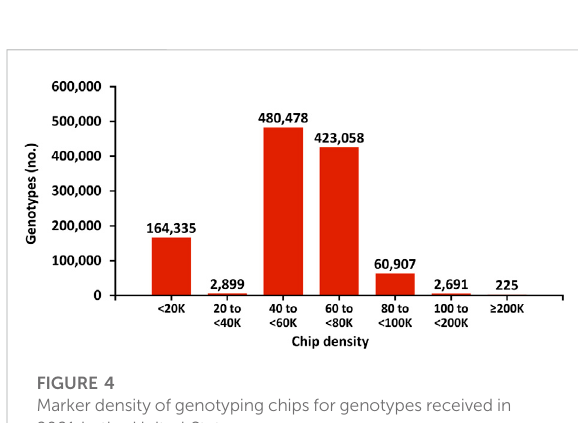
FIGURE 4 Marker density of genotyping chips for genotypes received in 2021 in the United